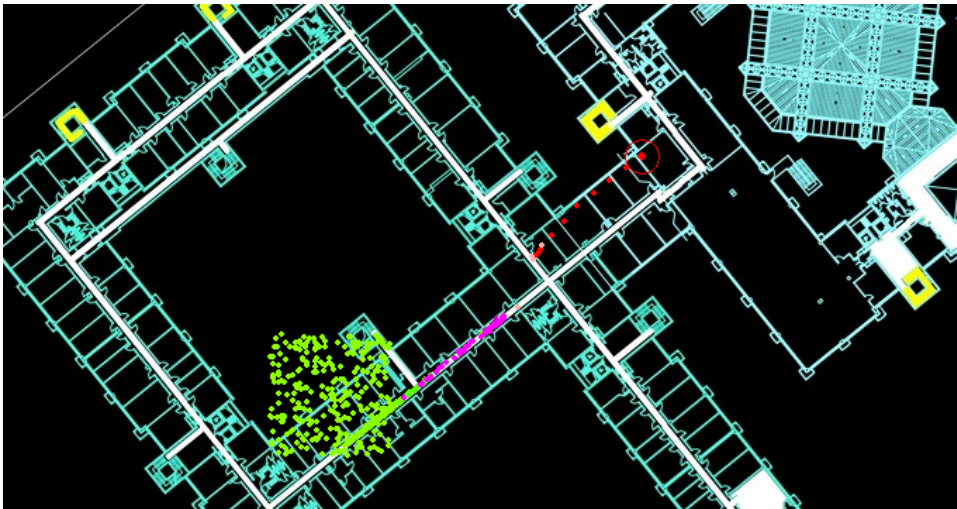
Figure 20. Negative effect of using geolocation service: The red double circle marks the true location while all the particles (marked as green dots ) are located far away due to low accuracy geolocation service signals.